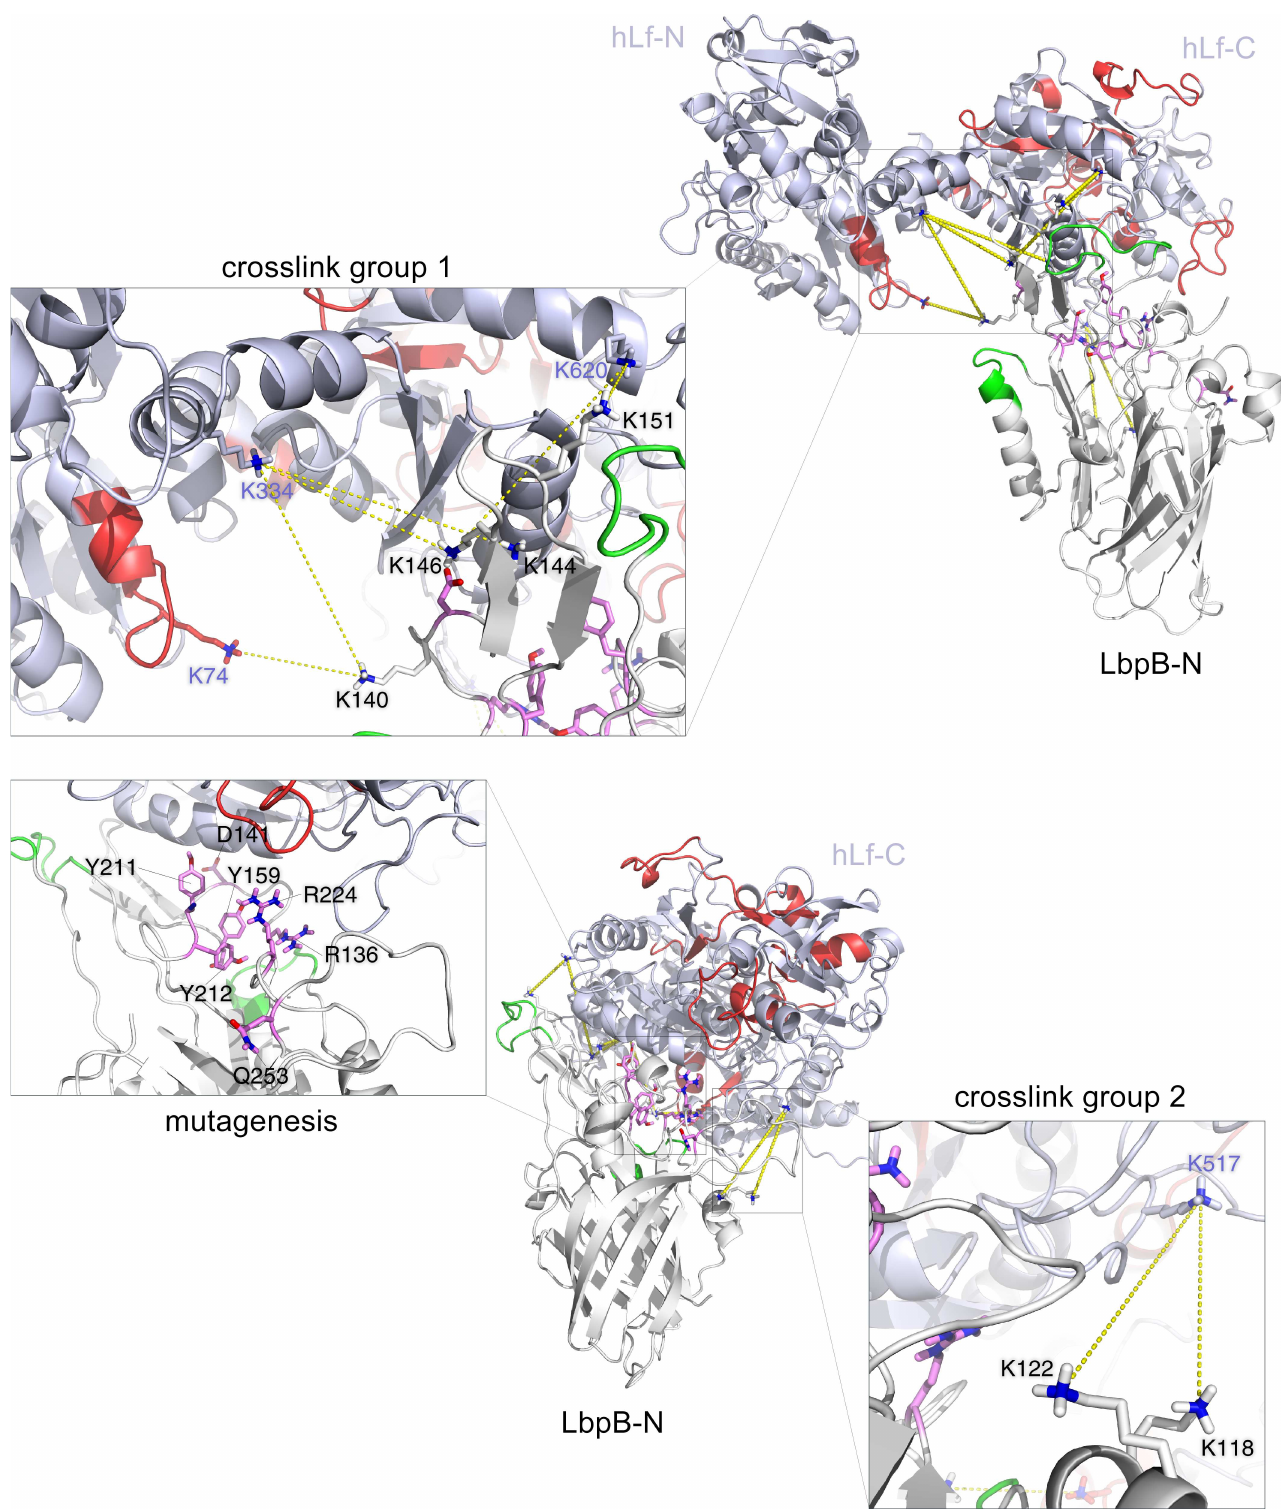
Fig 4. Data-directed docking model for the LbpB:hLf complex. The upper model shows the crystal structure of the LbpB-Nlobe (white) docked to hLf (pale blue) on its C-terminal lobe. Green and red regionscorrespondto protectedpeptidesin the LbpB:hLf complex(lower solvent accessibility) duringHX-MS experimentsfor LbpB and hLf, respectively. Residuesselectedfor mutagenesis which had an impact on